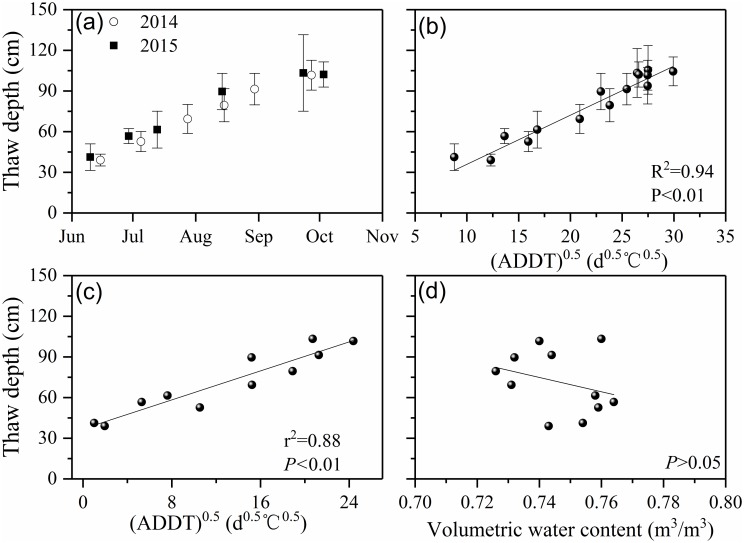
(a) Variability of thaw depths in summer, (b) thaw depth versus the square root of accumulated degree days of thaw (ADDT0.5) predicted by Stefan equation in summer 2014 and 2015 (bars indicate one standard deviation), thaw depth versus (c) ADDT0.5 of soil temperature and (d) unfrozen soil moisture at a depth of 20 cm.